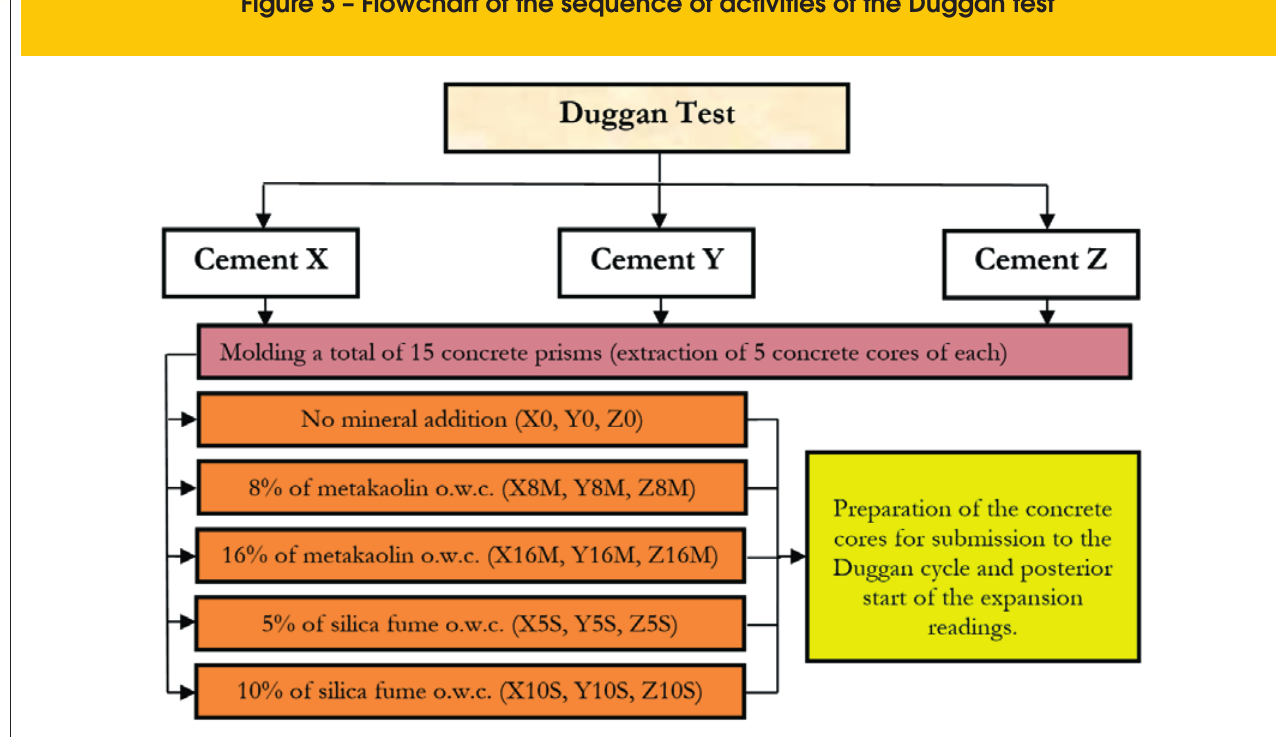
Figure 5 – Flowchart of the sequence of activities of the Duggan test